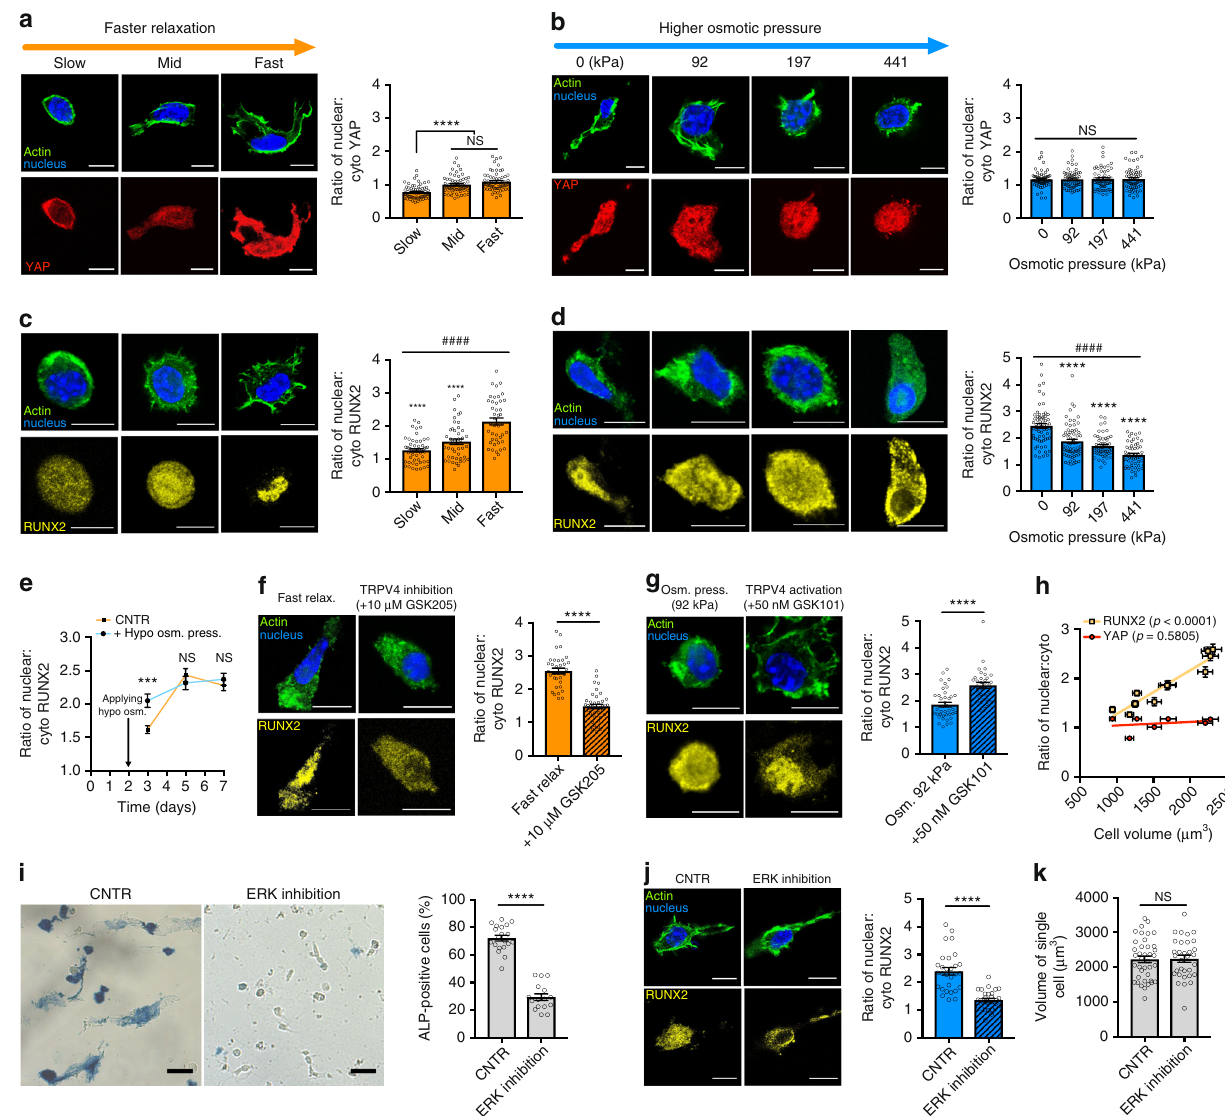
Fig. 6 Volume expansion enhances nuclear translocation of RUNX2 but not YAP. a , b Representative images of YAP (red), actin (green), and nucleus (blue) of MSCs cultured in hydrogels with varying stress relaxation ( a ) and in fast-relaxing hydrogels with altered osmotic pressure ( b ) for 7 days. Bar graphs indicates quanti fi cation nuclear:cytoplasmic YAP ratio. c , d Representative images of RUNX2 (yellow), actin (green), and nucleus (blue) of MSCs cultured in hydrogels with varying stress relaxation ( c ) and in fast-relaxing hydrogels with altered osmotic pressure ( d ) for 7 days. Bar graphs indicates quanti fi cation of nuclear:cytoplasmic RUNX2 ratio. e Quanti fi cation of nuclear:cytoplasmic RUNX2 for MSCs in hypoosmotic or control medium at days 3, 5, and 7. ( n ≥ 40 images from three replications per condition). f , g Representative images of RUNX2 (yellow), actin (green), and nucleus (blue) of MSCs cultured in fast-relaxing hydrogel with or without treatment of TRPV4 antagonist ( f ) and in mid relaxing hydrogel with or without treatment of TRPV4 agonist ( g ) for 7 days. Bar graphs indicate quanti fi cation of nuclear:cytoplasmic RUNX2. h Scatter plot of cell volume versus nuclear:cytoplasmic RUNX2 (yellow) and YAP (red) ratios. Linear regression analysis showed a trend of nuclear RUNX2 with cell volume. Nuclear:cytoplasmic ratios were quanti fi ed with n ≥ 60 images from three biological replications per condition. i Representative images of ALP staining and quanti fi cations of ALP-positive cells for MSCs cultured in fast-relaxing hydrogels with or without treatment of the ERK inhibitor for 7 days ( n ≥ 15 images from three replications per condition). Scale bar, 25 µ m. j Representative images of RUNX2 (yellow), actin (green), and nucleus (blue) and quanti fi cation of the nuclear:cytoplasmic RUNX2 ratio ( n ≥ 30 images from three replicates). k Quanti fi cation of the volume of single cells cultured in indicated conditions ( n ≥ 30 cells from three replications per condition). Scale bar in all immunostaining images is 10 µ m. All data are shown as mean ± s.e.m. For one-way ANOVA comparisons and Student ’ s t test; * p <0.05, ** p <0.01, *** p <0.001, and **** p <0.0001 and for Spearman ’ s rank correlation; #### p